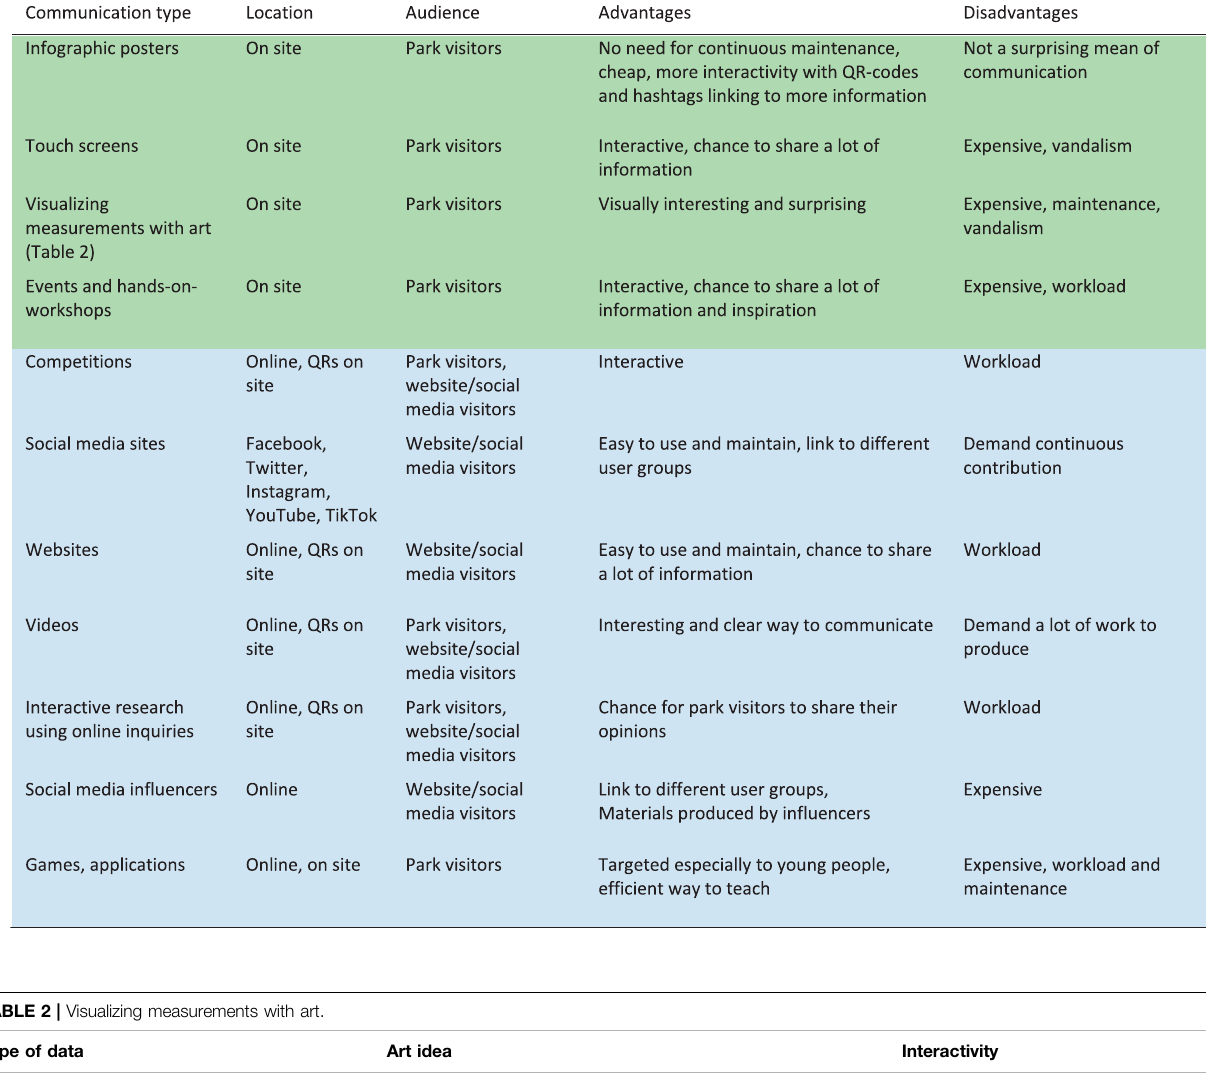
TABLE 1 | Different communication and engagement methods: green — on site and blue – online.